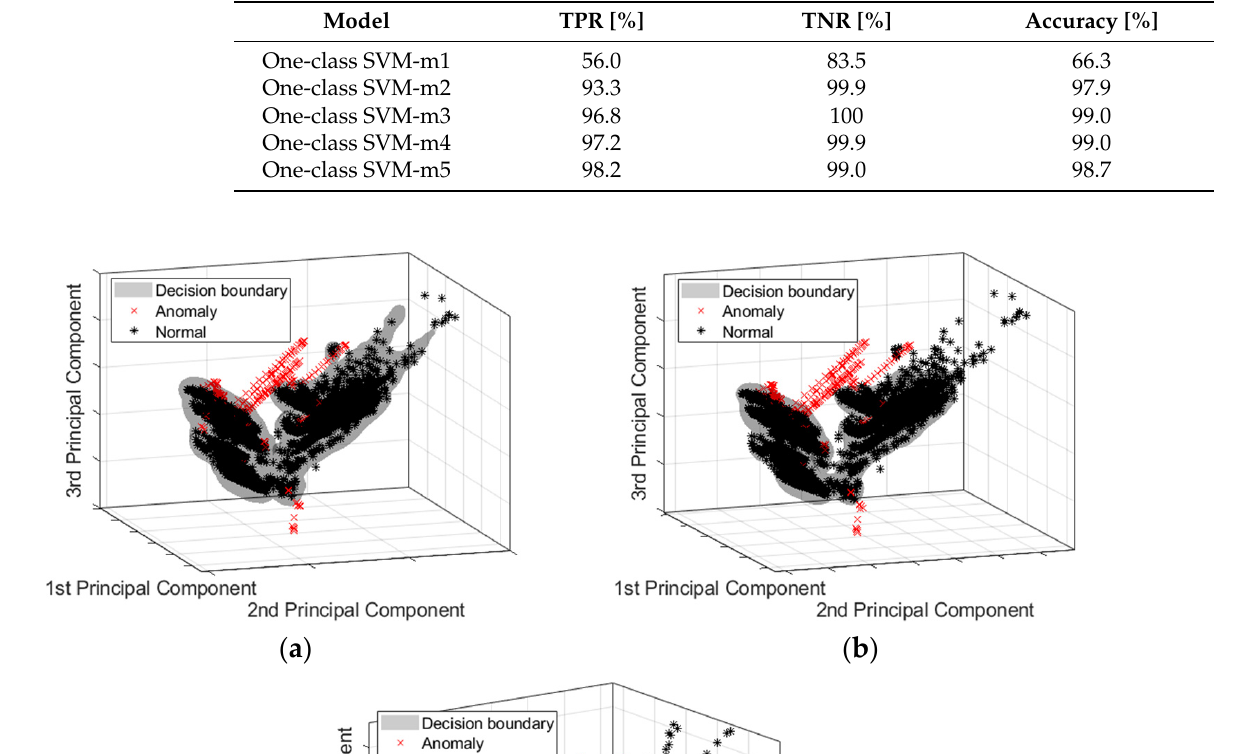
Table 12. Test results of the one-class SVM-based anomaly detection models.